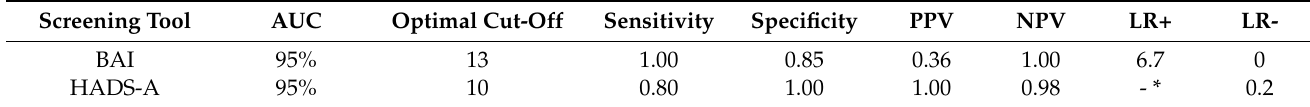
Table 3. Characteristics of the BAI and